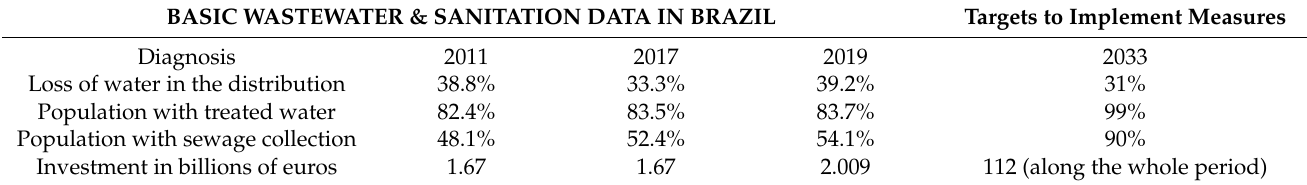
Table 2. Annual water and sewage diagnosis, 2019